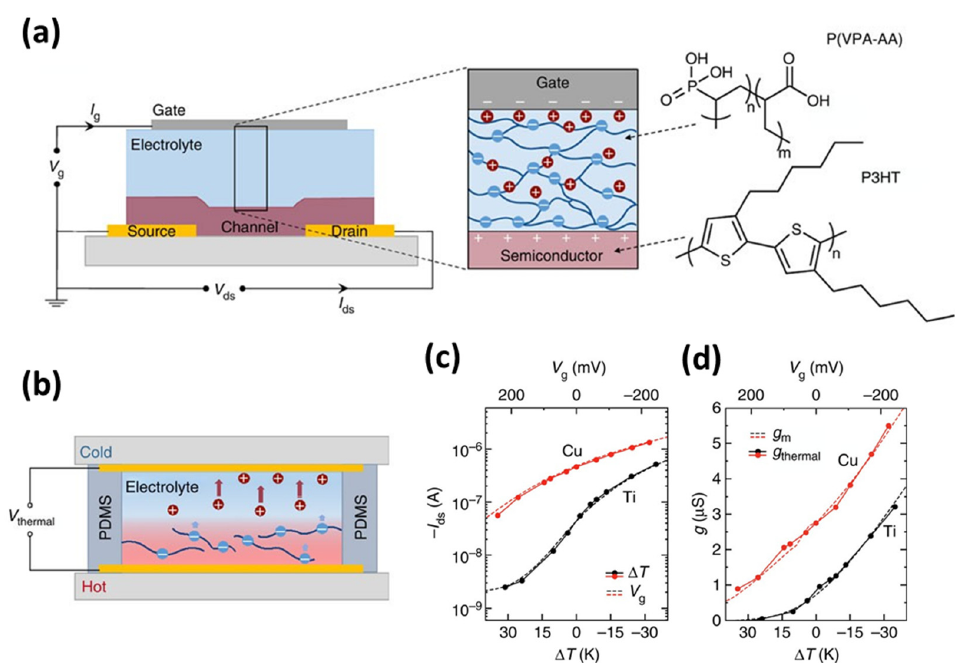
Figure 8. ( a ) Structure of the electrolyte-gated transistor with a negative bias applied to the gate with the formation of EDLs and the chemical structures of P3HT and P(VPA-AA); ( b ) Structure of the ionic thermoelectric supercapacitor (ITESC), where positive charges are Na + cations and negative charges are immobile alkoxylate and carboxylate anions; ( c ) The transfer characteristics; ( d ) Transconductance of ionic thermoelectric-gated transistors using Cu and Ti as the gate electrode versus the temperature change ( Δ T ). Reproduced with permission from [93] Springer Nature, 2017. Note: V g is V GS . Table 2. Summary of polymer semiconductor-based OFET temperature sensors.